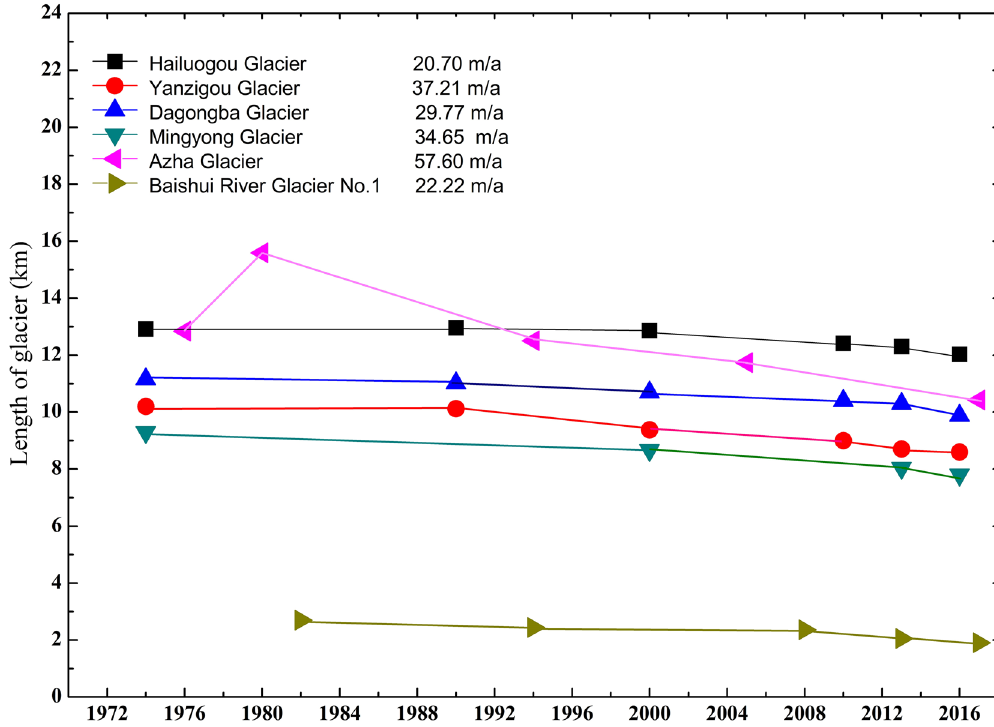
Figure 3. Length change of typical temperate glaciers from the 1960s to the